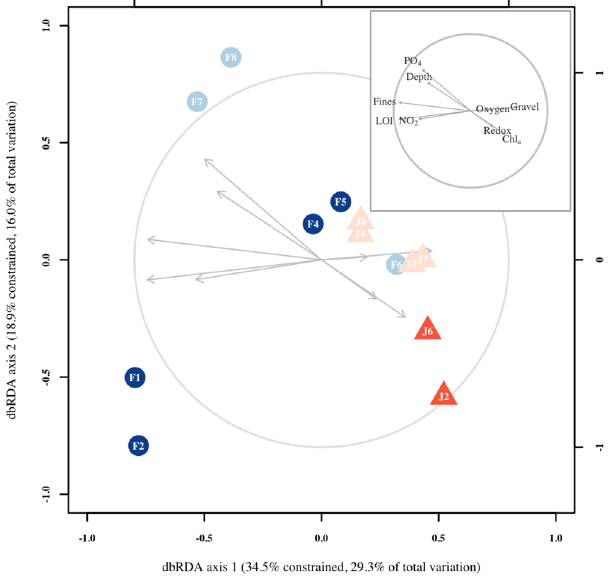
Figure 6. Distance-based redundancy analysis plot of square-root-transformed macrobenthic data with Bray- Curtis similarity index. Vectors are shown only for the most relevant environmental variables in the model. Length and direction of vectors indicate the strength and direction of the relationship. PO 4 , phosphates; NO 2 , nitrites; Chla, chlorophyll a ; LOI, loss on ignition; Redox, reduction potential; Fines; > 63 μ m grain size